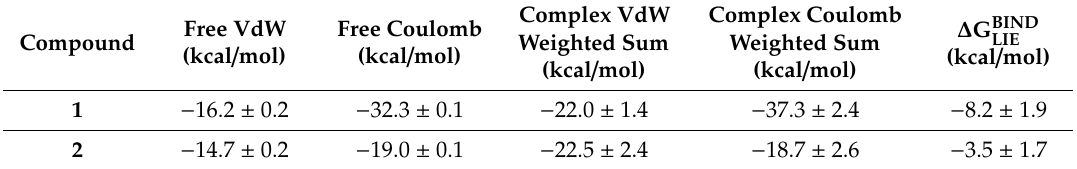
Table 2. Calculation of binding free energies for compounds 1 and 2 using LIE